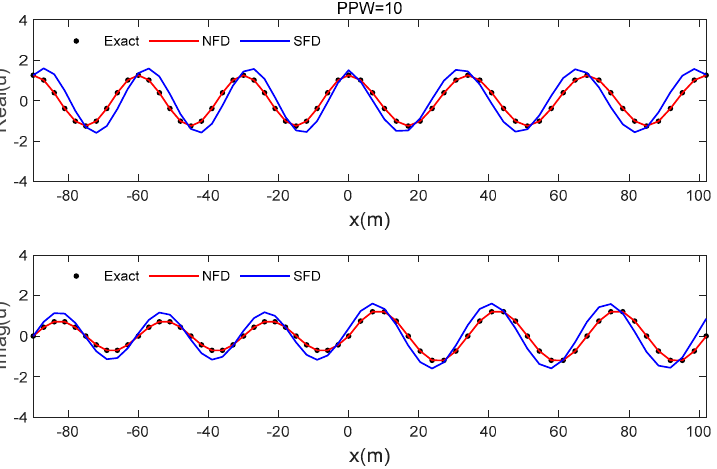
Figure 4. The real and imaginary parts of solutions in the plane-wave reflection case with PPW = 10.